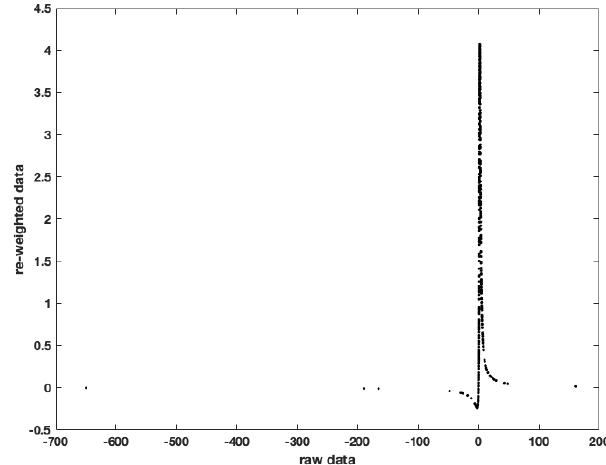
Figure 2. Transformation of outcomes in mle estimation of the mean of a t distribution with location 2.0, scale 1 and 1.1 degrees of freedom. Based on a sample of 500 observations. Outcomes in the tails of the distribution are not truncated; instead, they are mapped close to zero, eliminating their impact. Outcomes close to the (estimated) mean have maximum influence; they are mapped into the highest and lowest values. The transformation is